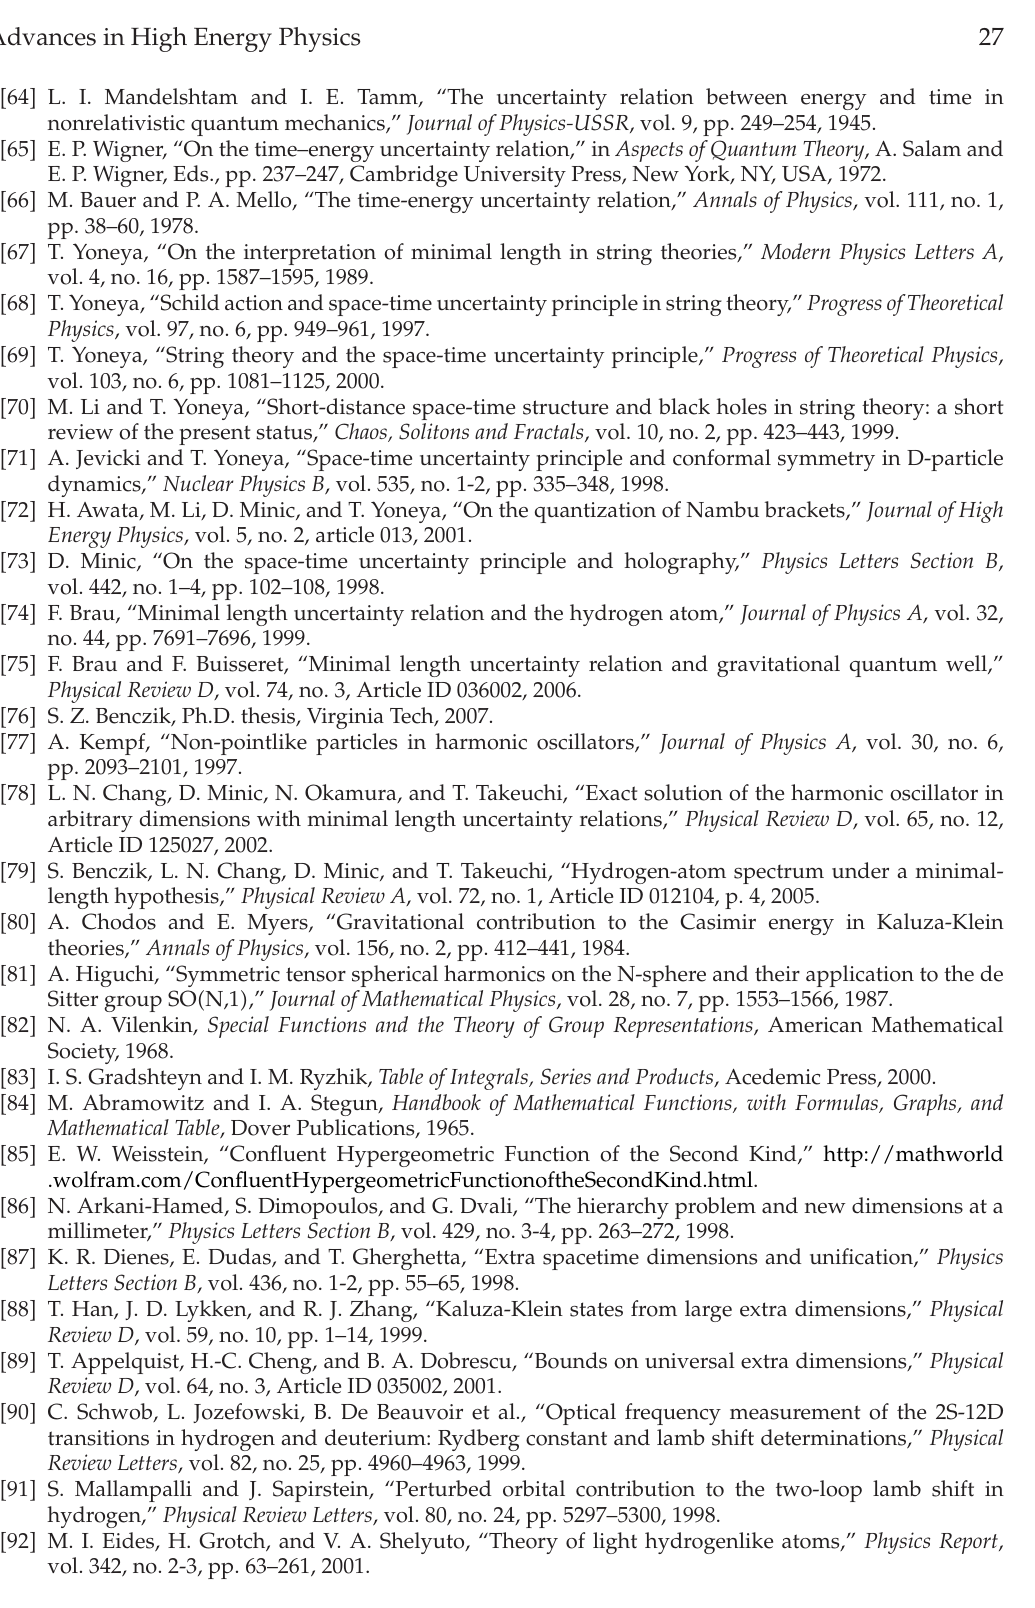
Mathematical Table , Dover Publications, 1965. (cid:2) 85 (cid:3) E. W. Weisstein, “Confluent Hypergeometric Function of the Second Kind,” http://mathworld .wolfram.com/ConfluentHypergeometricFunctionoftheSecondKind.html. (cid:2) 86 (cid:3) N. Arkani-Hamed, S. Dimopoulos, and G. Dvali, “The hierarchy problem and new dimensions at